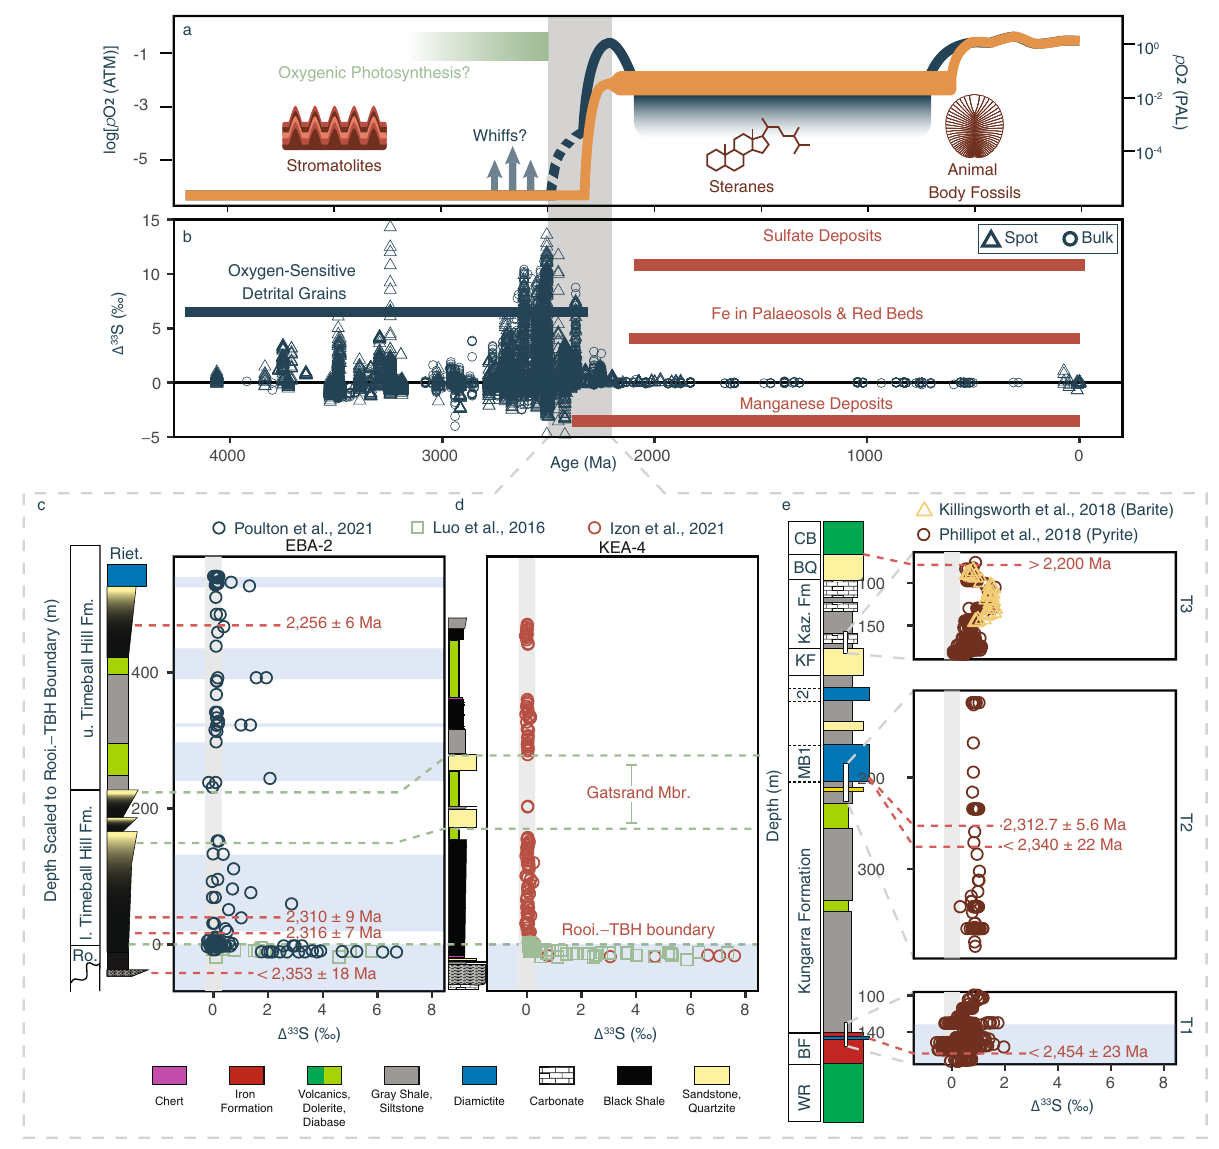
Fig. 1 | Synthesised interpretations of Earth ’ s oxygenation. a A schematic representation of competing ideas surrounding the oxygenation of Earth ’ s atmosphere 1 contextualised within a framework of biological innovations. b The secular evolution of Δ 33 S values compiled herein (Supplementary Data File 1). The grey box locates the interval over which atmospheric oxygen is thought to have fi rst accumulated, while the horizontal bars illustrate more traditional redox indicators,whoseredandbluecolourationdiscriminatesbetweenthosedisclosing oxicandanoxicconditions,respectively 4,5 .Triangularandcircularpointsrepresent spot and bulk Δ 33 S analyses respectively. Stratigraphic distributions of Δ 33 S data from the South African Kaapvaal ( c core EBA-2; d core KEA-4) and Western Aus- tralian Pilbara ( e cores T1 – T3) cratons, whose discrepant interpretations have led to the emergence of con fl icting models of atmospheric oxygenation. Each of the chronologically constrained lithostratigraphic columns follow those presented with the Δ 33 S data 22,25,30,32,33 , with the superimposed vertical grey bars illustrating